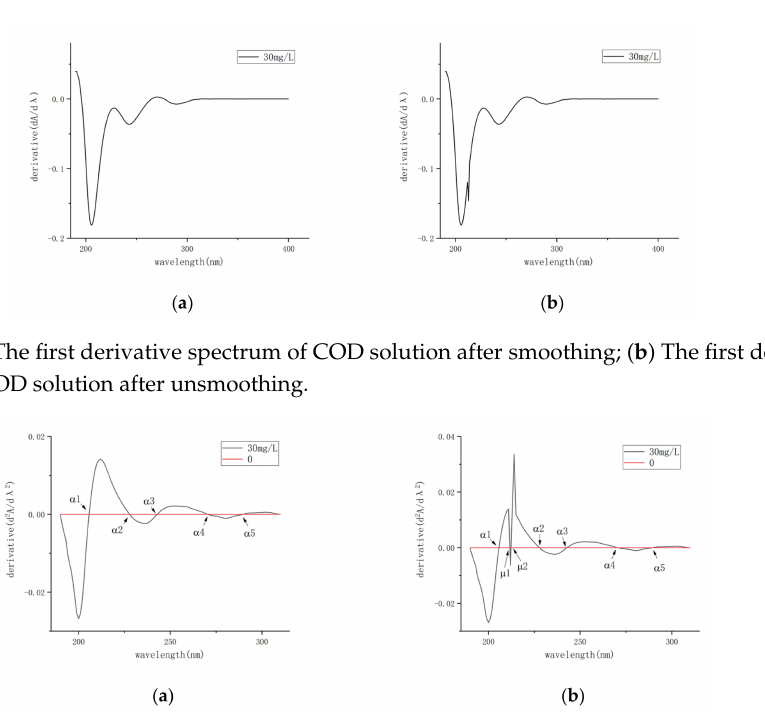
Figure 11. ( a ) The second derivative spectrum of COD solution after smoothing; ( b ) The second derivative spectrum of COD solution after